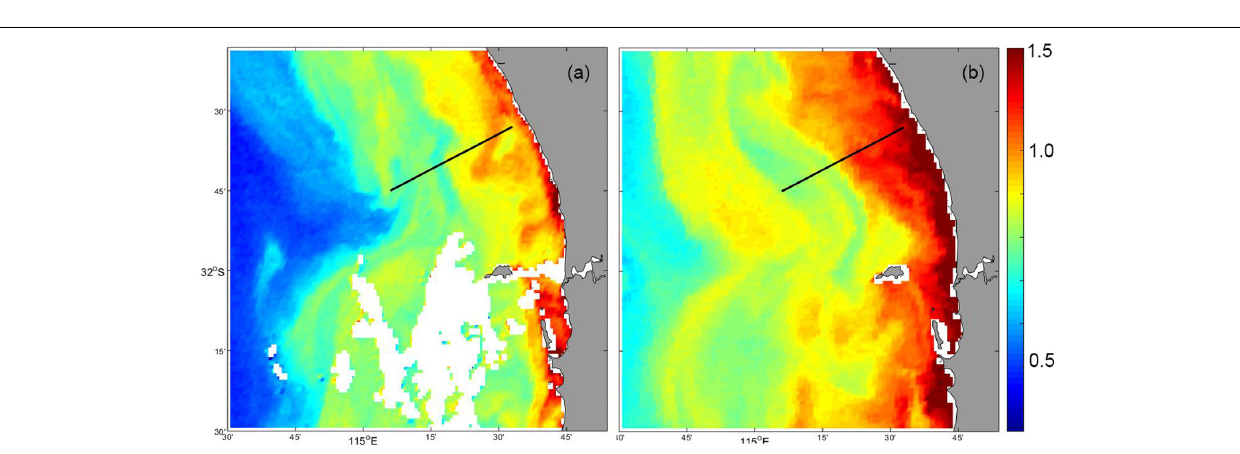
FIGURE 12 | MODIS satellite derived surface chlorophyll concentration: (a) 17 May 2016; and (b) 30 May 2016. The glider transect is shown as the dotted